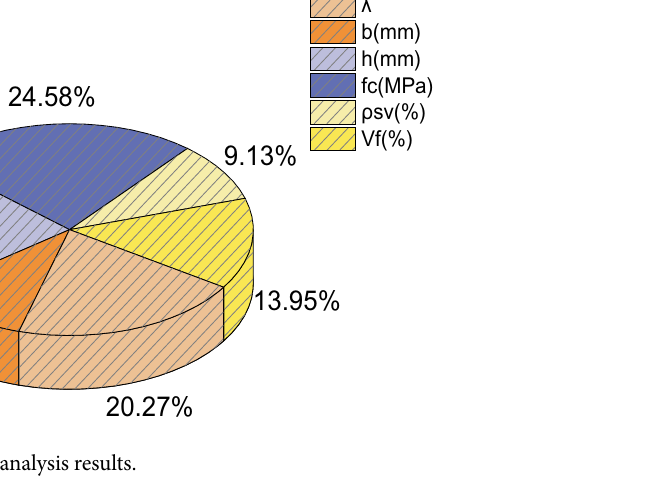
Figure 22. Sensitivity analysis